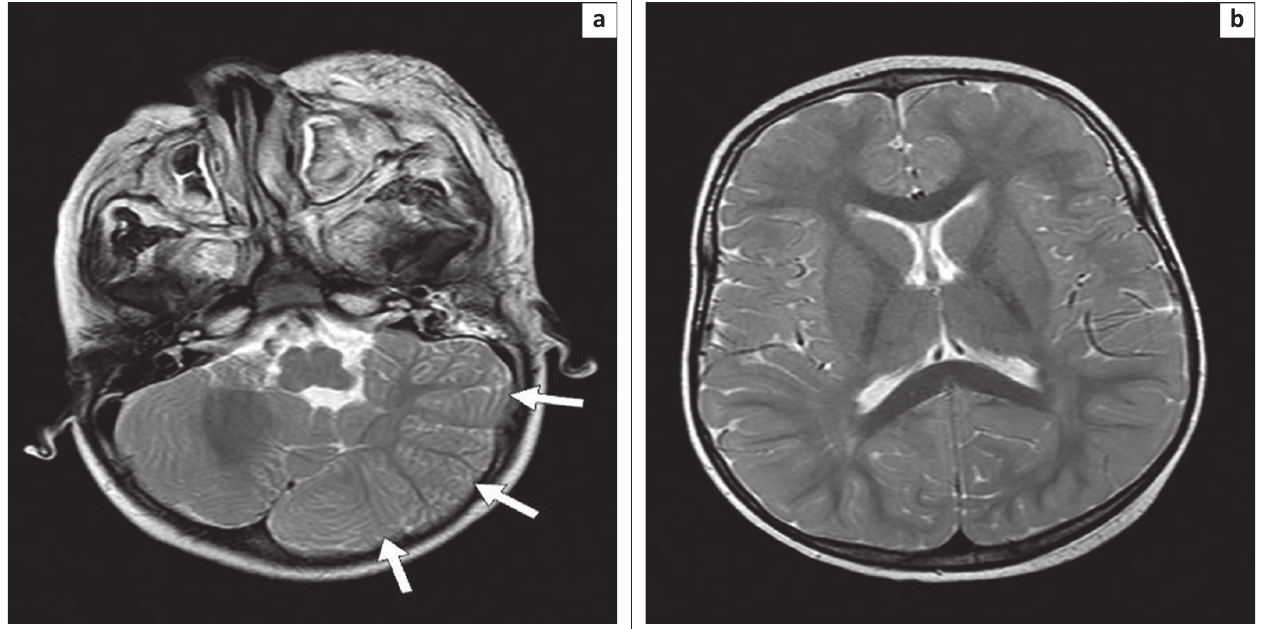
FIGURE 2: (a) Axial T2W MRI image of the posterior fossa demonstrates enlargement of the left cerebellar hemisphere (arrows) with midline shift to the right. (b) Note the normal size of the cerebral hemispheres on axial T2W MRI image more